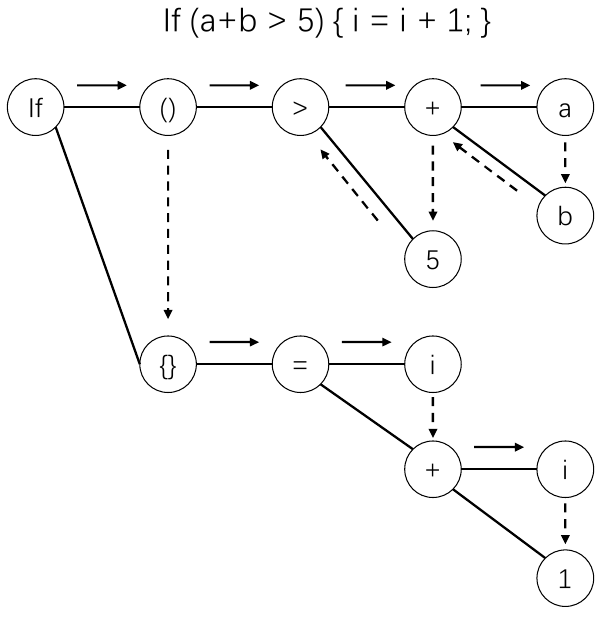
Figure 4. Path from root to